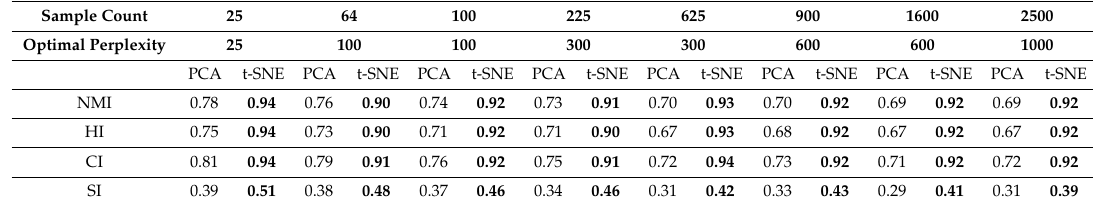
Table 2. Results obtained for different sample sizes and optimal perplexity.